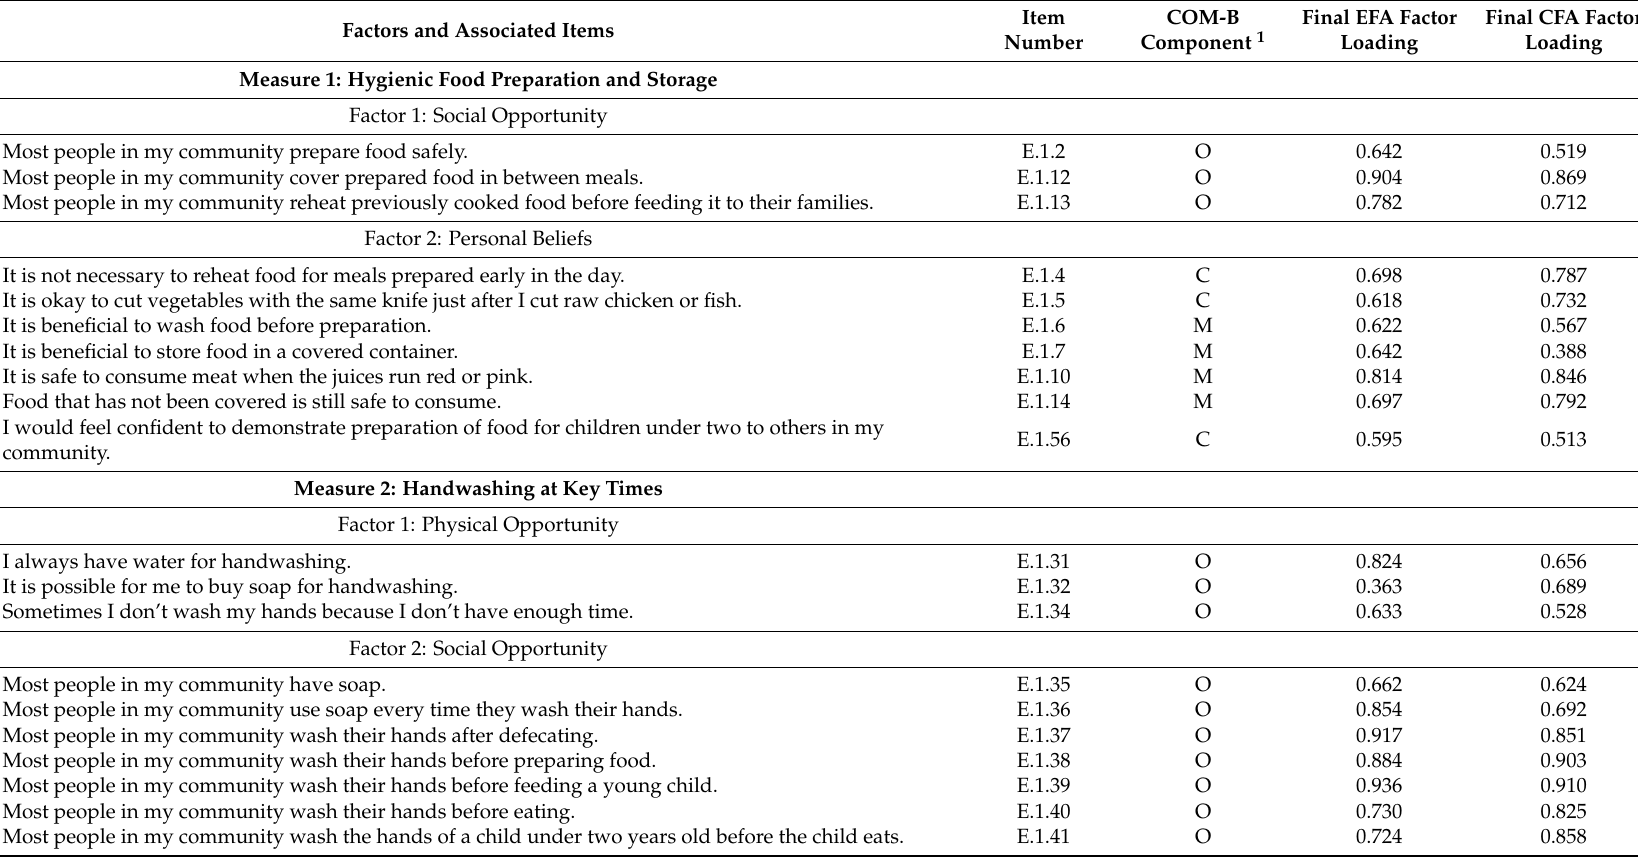
Table 4. Exploratory and confirmatory factor analysis results for hygienic food preparation and storage behaviors measure, handwashing behaviors measure, and safe play environment provision measure (n EFA = 135; n CFA = 135).